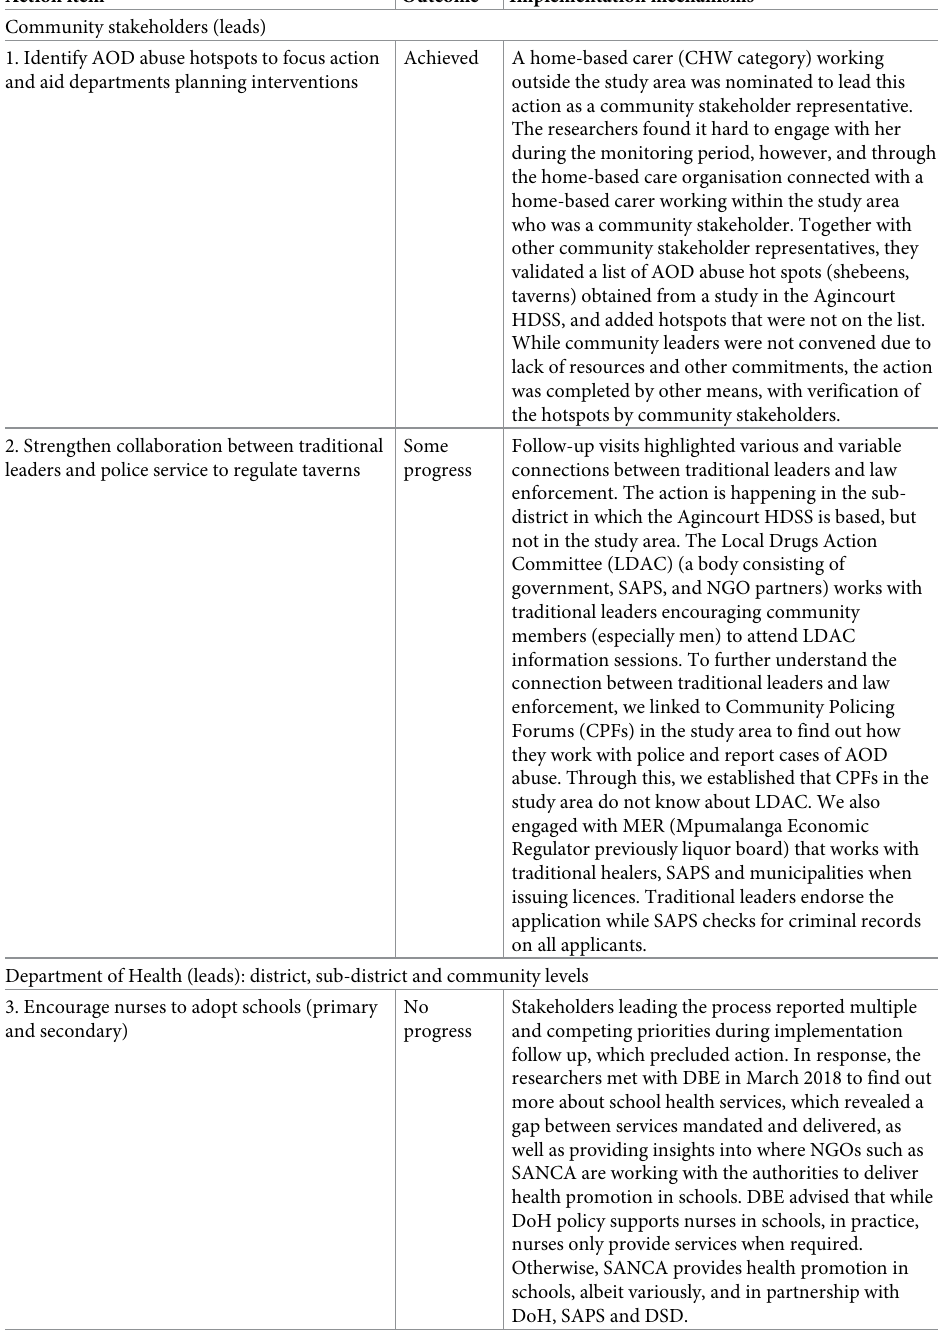
Table 1. Progress towards the Local Action